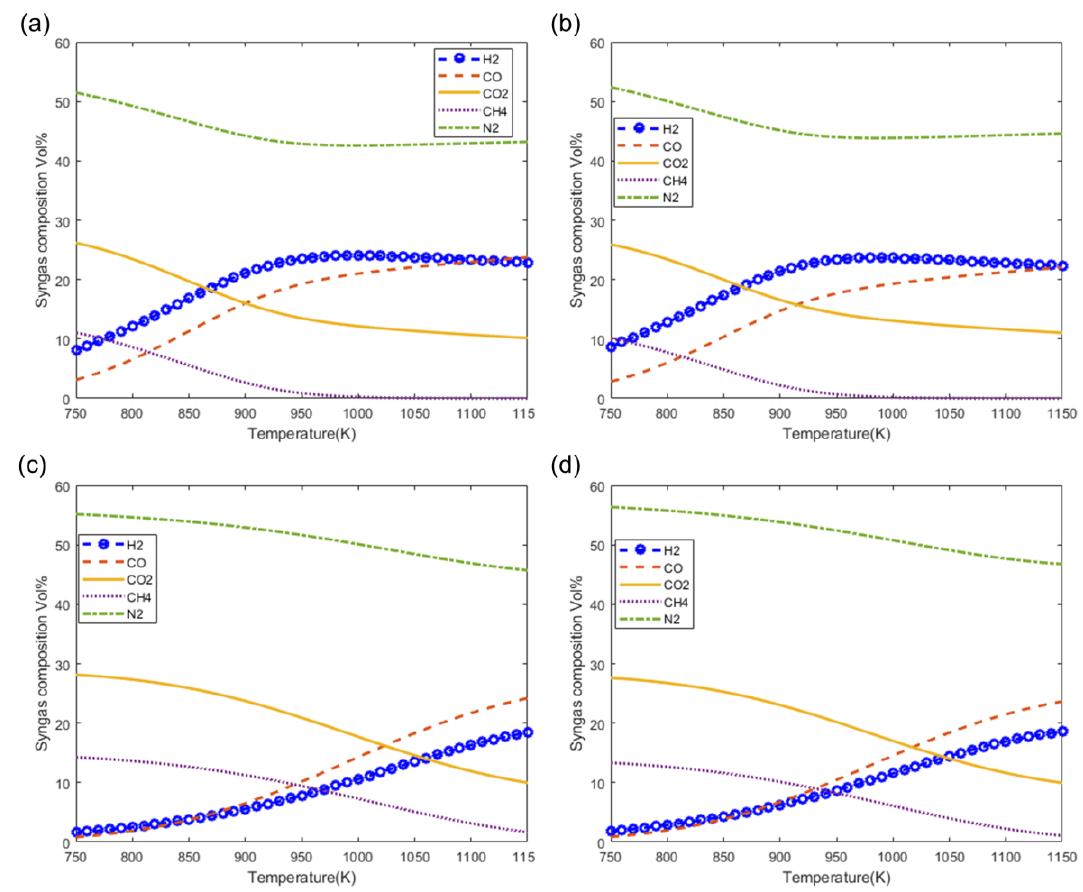
Figure 9. Effect of gasification temperature on syngas composition at MC = 20%. ( a ) M1, ( b ) M2, ( c ) M3 and ( d ) M4.